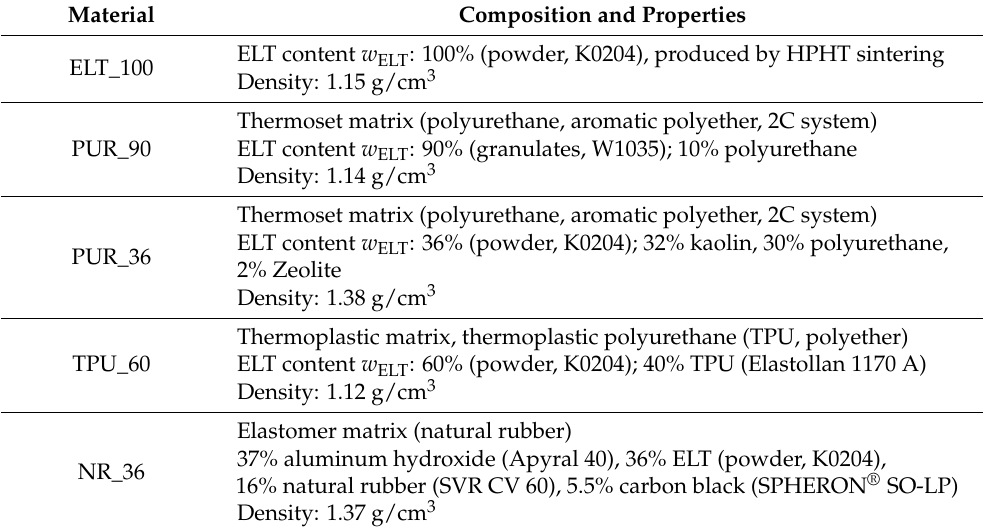
Table 2. Material composition of the blends.